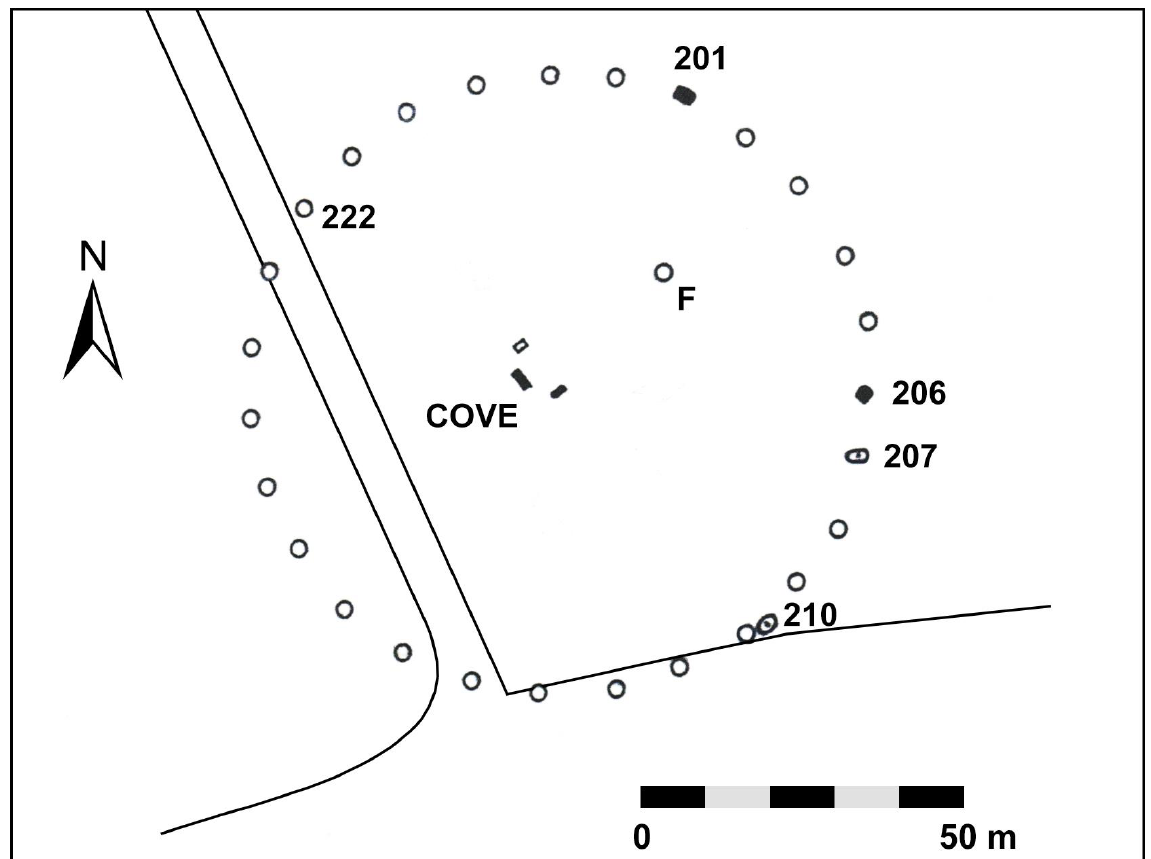
Figure 15. Plan of the North Circle at Avebury centred by the Cove. Note the position of Stone F that functions at Avebury in the same manner as the Heel Stone at Stonehenge and portal Stone 1 at Drombeg. Drawn by the author after Smith (1965: 205, fig.